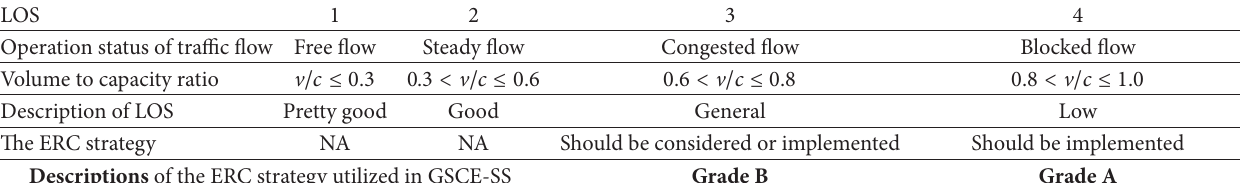
Table 4: Grades of freeway LOS in China and the implementation criteria for ERC.